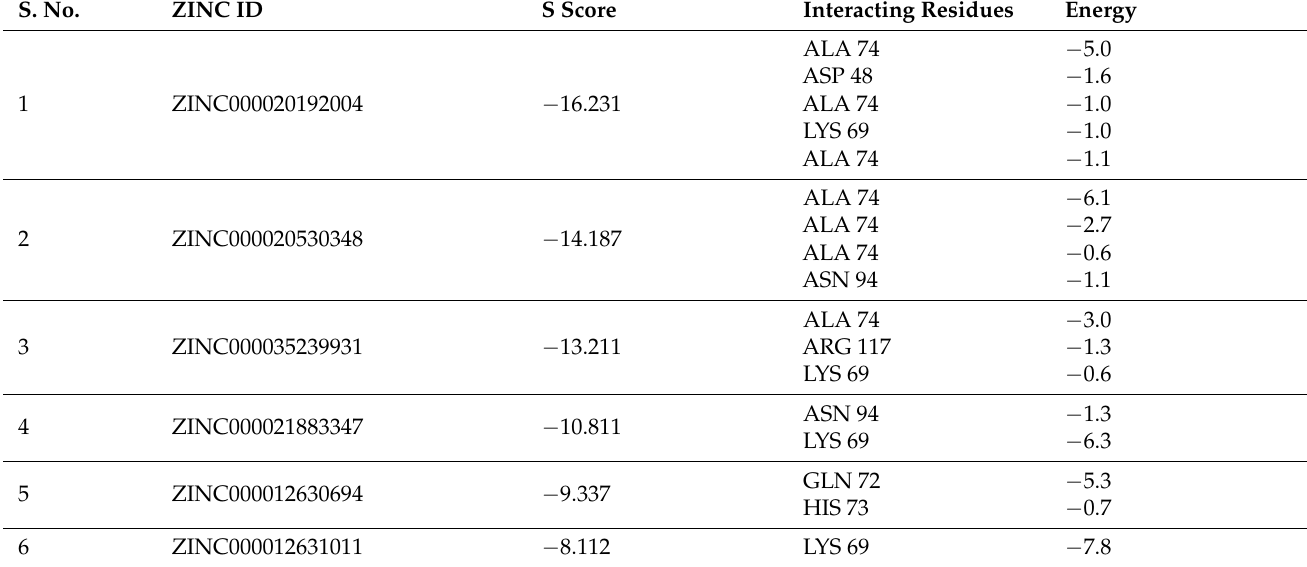
Figure 5. Hydrogen bond interaction of ZINC000020192004 with the drug target. Table 5. Molecular docking of the most favorable interacting compounds.